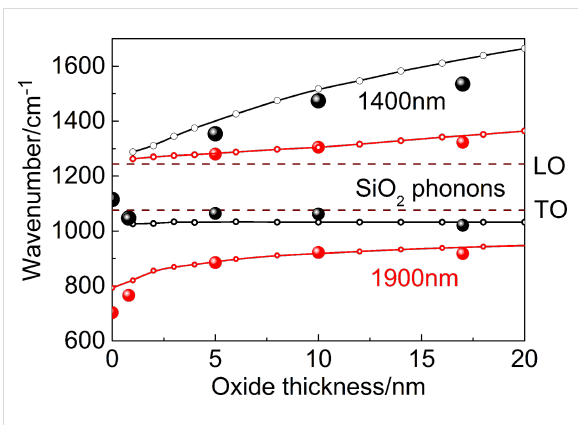
Figure 7: Splitting the LSPR modes due to plasmon–phonon interac- tion for nanoantennas with the lengths of 1400 and 1900 nm. Large circles: experiment; solid lines with dots: full-wave